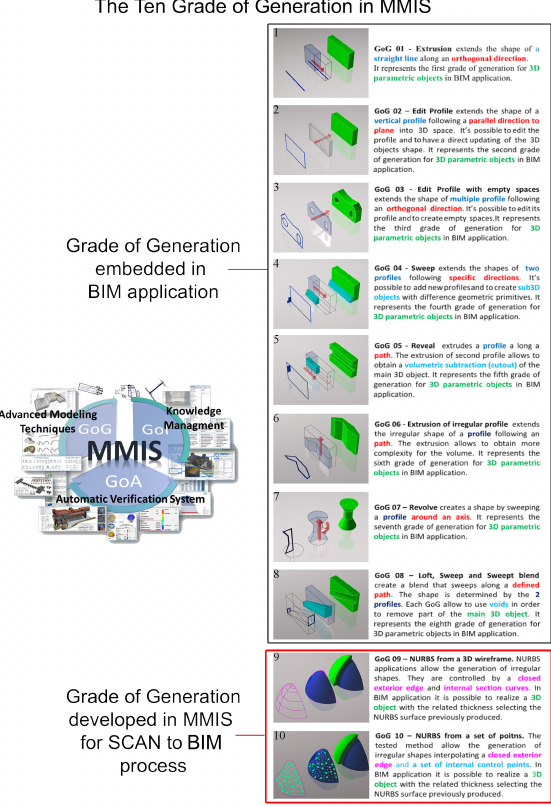
Figure 2. Novel Scan-to-BIM modeming requirements: the ten Grade of